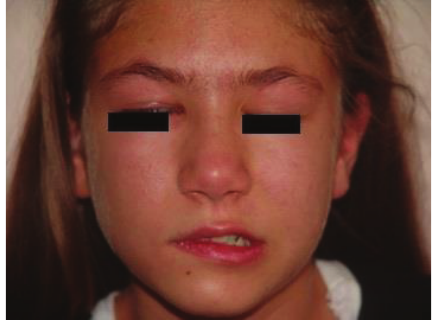
Figure 1: Grade 4 peripheral facial paralysis on the right.